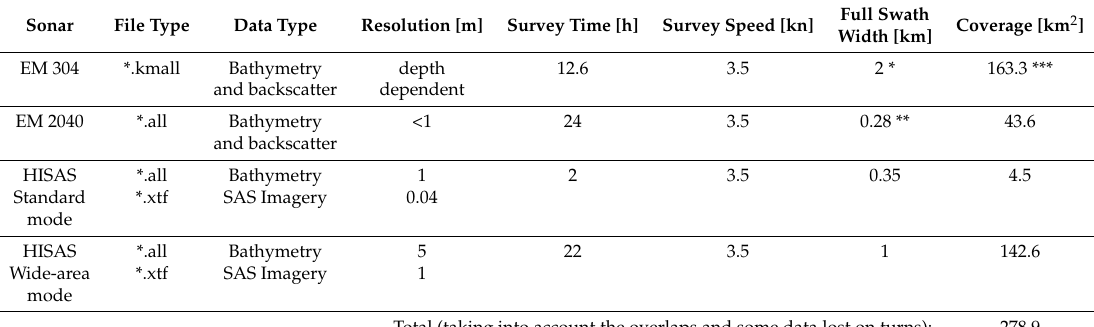
Table 7. Data types collected and processed during the 24 h survey with basic